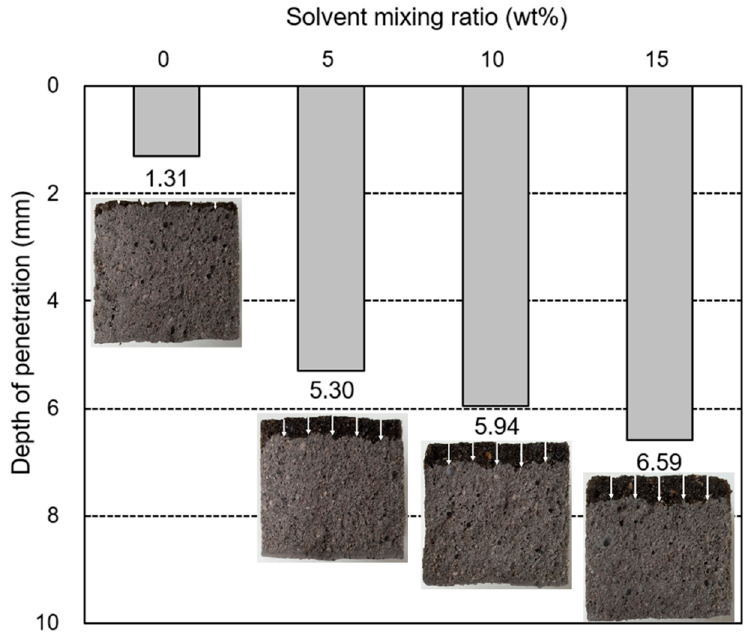
Figure 7. Penetration depth of epoxy resin based on the solvent mixing ratio.